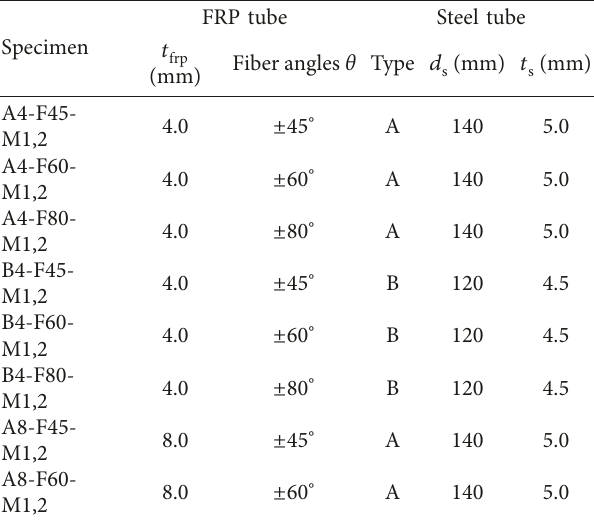
Table 1: Details of specimens. FRP tube Steel Specimen